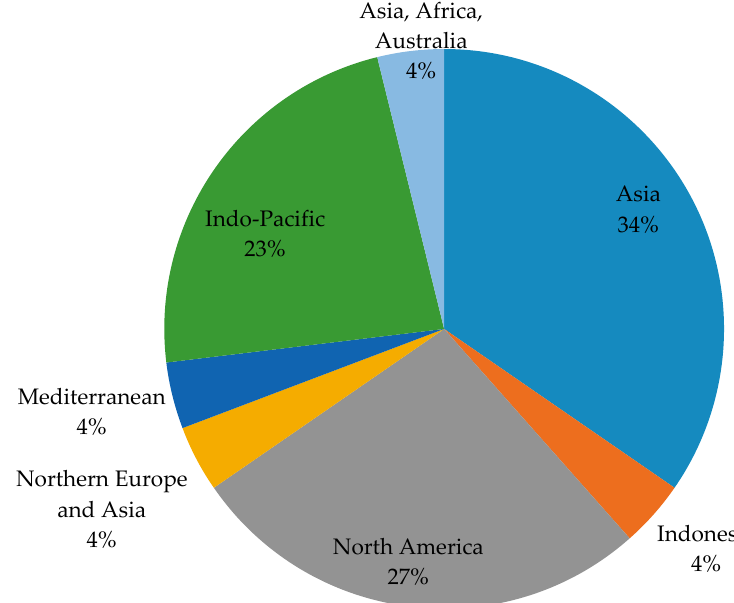
Figure 4. Geographical origin of the potential IAS in the Baltic Sea.